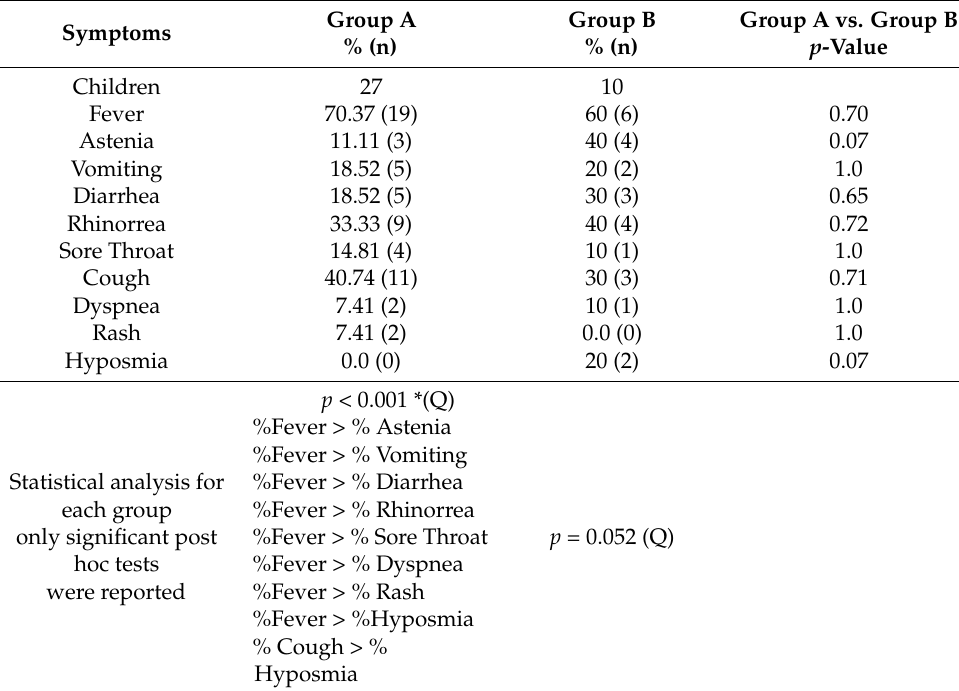
Table 3. Symptoms of COVID-19